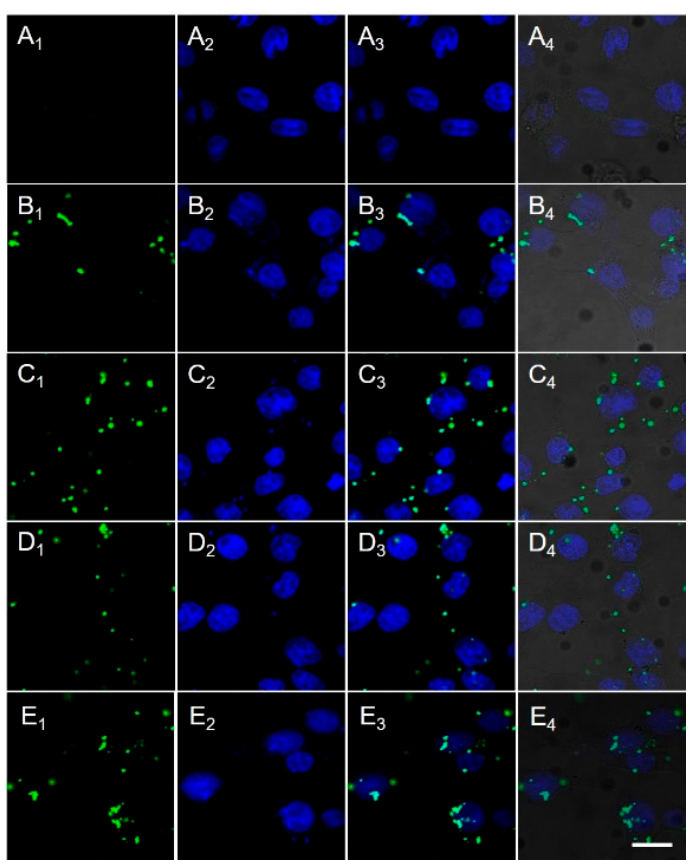
Figure 3. Cellular uptake of ( A ) naked DNA; ( B ) PLL/DNA complexes; ( C ) pNLS/DNA complexes; ( D ) pNLS/DNA/AuNC complexes; and ( E ) intracellular distribution of pNLS/DNA/AuNC complexes after NIR irradiation. The DNA stained with YOYO-1 are shown with green fluorescence in A 1 , B 1 , C 1 , D 1 , E 1 . The nuclei stained with Hoechst 33342 are shown with blue fluorescence in A 2 , B 2 , C 2 , D 2 , E 2 . The fluorescent channels are merged in A 3 , B 3 , C 3 , D 3 , E 3 . The fluorescent channels and bright field are merged in A 4 , B 4 , C 4 , D 4 , E 4 . Scale bar: 20 µ m. (Green channel: excitation at 488 nm, emission at 500–550 nm; blue channel: excitation at 405 nm, emission at 440–460 nm).